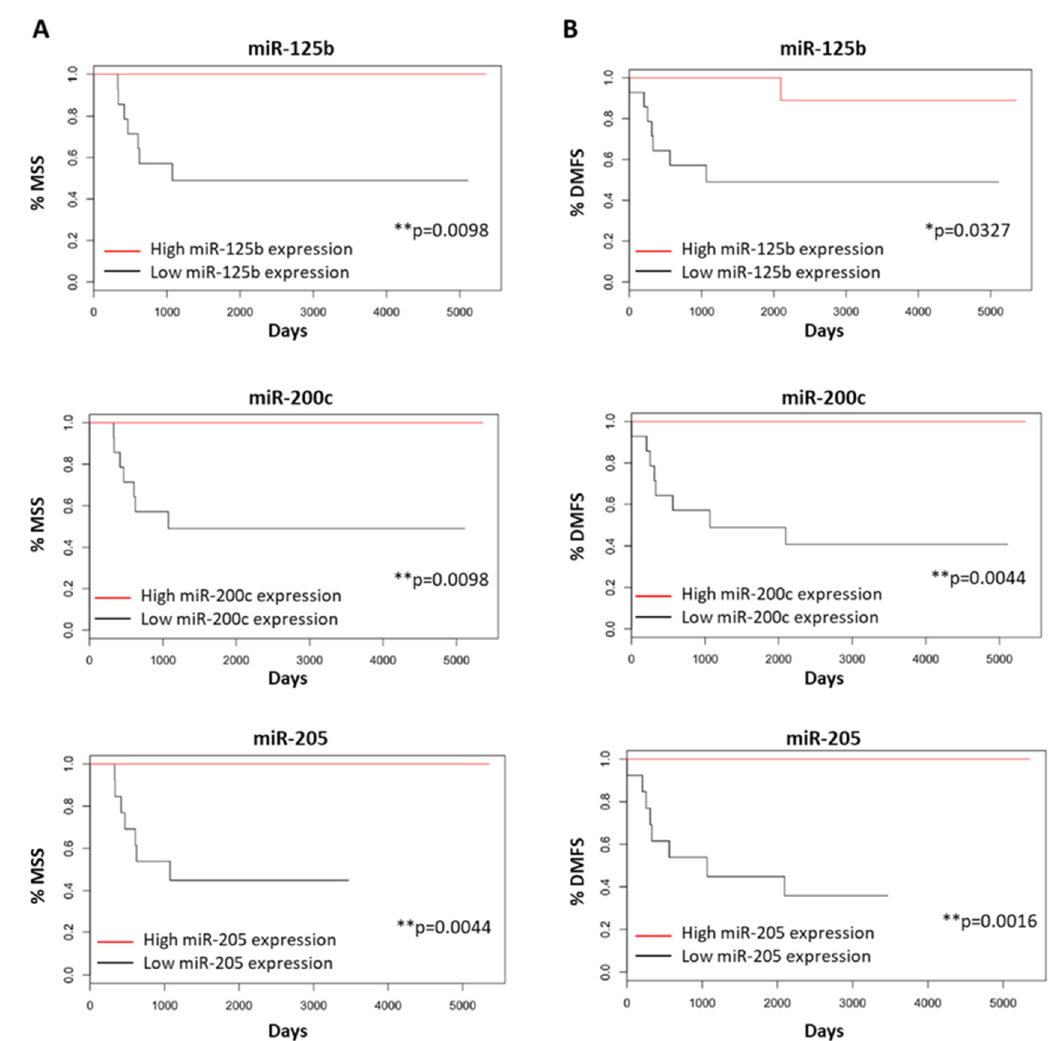
Figure 6. Kaplan–Meier curves for MSS and DMFS of BRAF WT primary melanoma patients depending on miR-125b, miR-200c and miR-205 expression being below (black) or over (red) their corresponding median expression values. Influence of miR-125b, miR-200c and miR-205 expression affecting ( A ) MSS and ( B ) DMFS of patients, respectively. Significant at * p -value < 0.05, ** p -value < 0.01. In patients with BRAF mutated primary melanomas, MSS and DMFS were significantly longer in patients showing miR-125b (MSS rate = 94.74% vs. 57.89% p -value = 0.0066 and DMFS rate = 84.71% vs. 50.33%, p -value = 0.0221) and miR-200c (MSS rate = 90.48% vs. 59.32%, p -value = 0.0158 and DMFS rate = 85.45% vs. 46.39%, p -value = 0.0041) expression levels above the median. Patients with any BRAF mutation showing miR-205 expression levels over the median also revealed a DMFS that was significantly longer (DMFS rate = 89.47% vs. 46.20%, p -value = 0.0036) but not a significantly longer MSS (Figure 7).